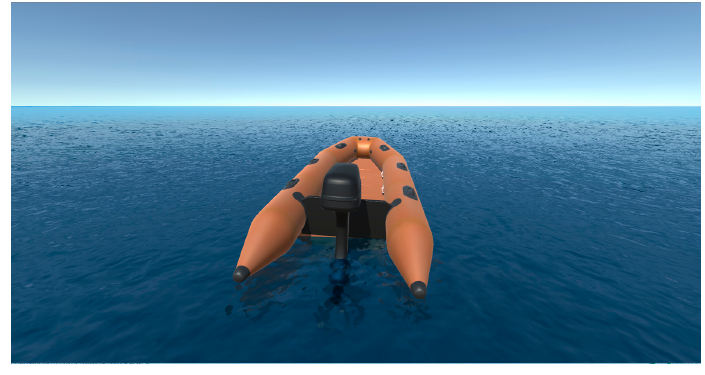
Figure 2. Snapshot of the visual module of a speedboat simulator.